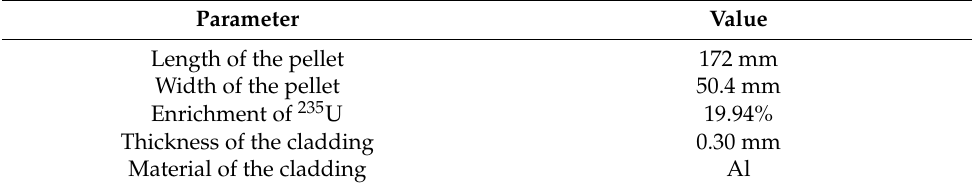
Table 1. Main parameters of nuclear fuel